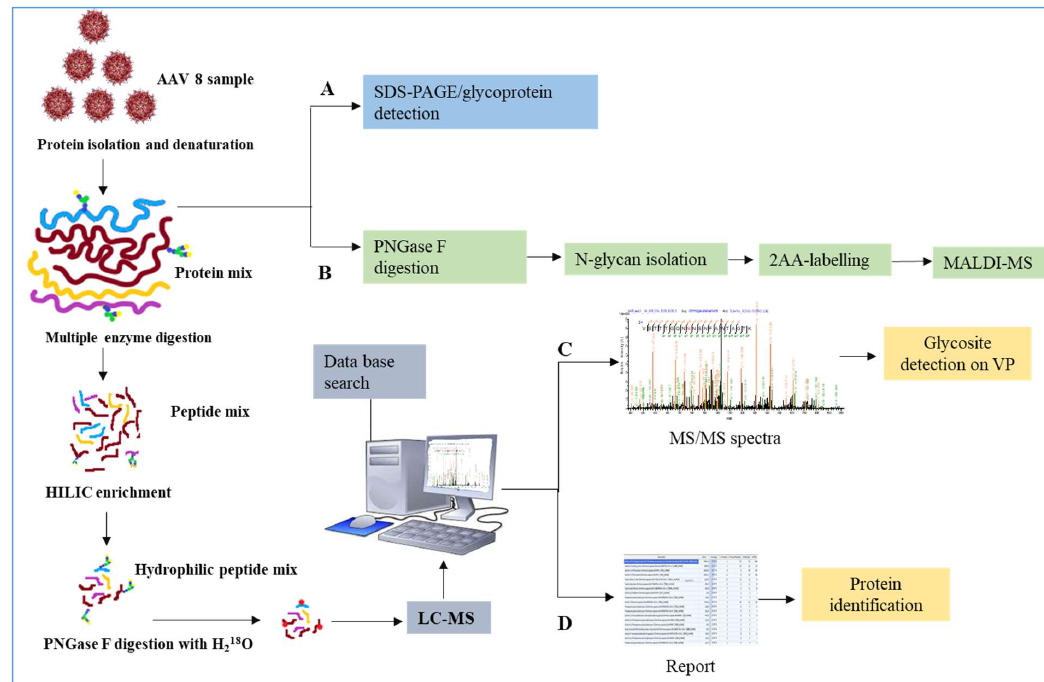
Figure 1. Intracellular or secreted Adeno associated virus (AAV)8 were processed in parallel and analyzed using multiple techniques. ( A ) Samples visualized on the SDS-PAGE gel by glycoprotein labelling. ( B ) N-glycan analysis using MALDI-MS identifies the type of glycosylation. The peptides generated by Glu C or trypsin digestion were enriched using HILIC cartridges. Deglycosylation of enriched glycosylated peptide in the presence of H 218 O labelled the glycosite with 18 O. ( C ) The samples were injected to LC-MS and using the database of AAV8 VPs, the N-glycosite was identified ( D ) The with